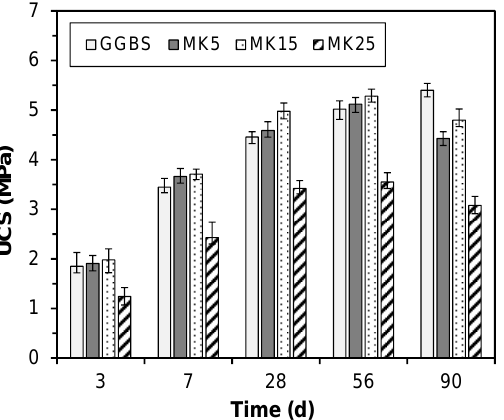
Figure 10. MK ’s effect on AAS- CPB’s strength development . Figure 10. MK’s effect on AAS-CPB’s strength